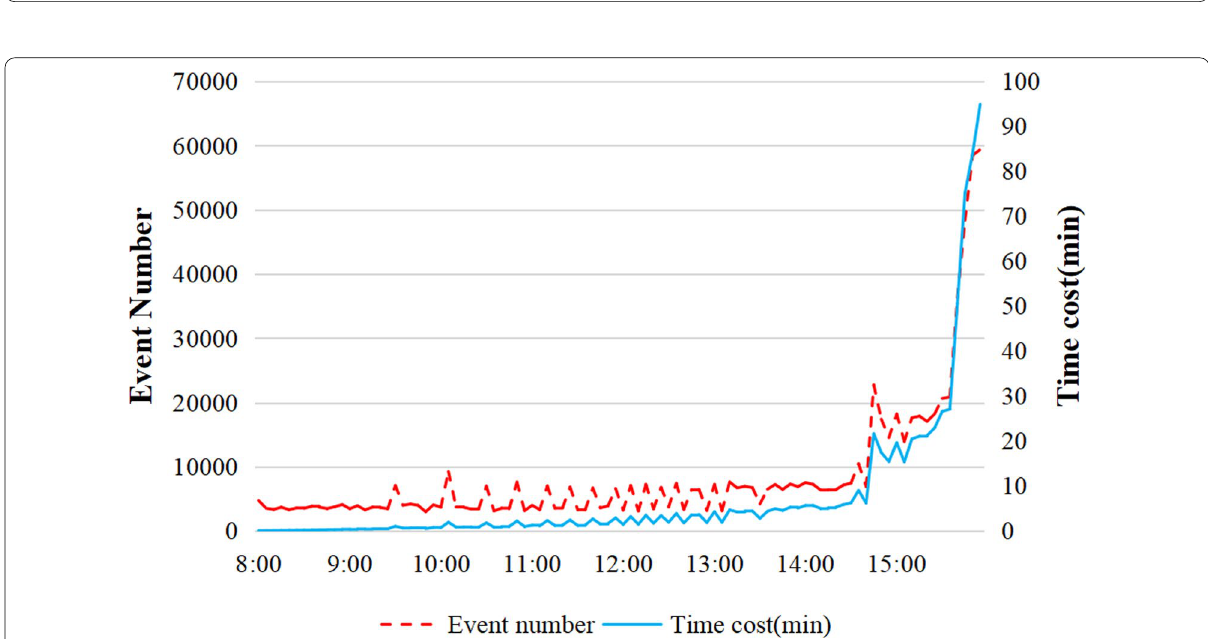
Fig. 7 Time cost (min) for Linux server without